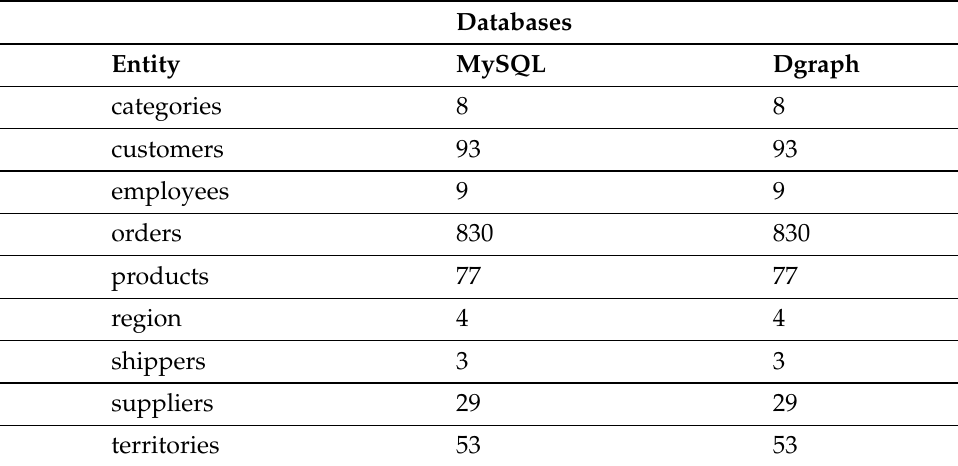
Table 3. Number of migrated elements from MySQL to Dgraph.